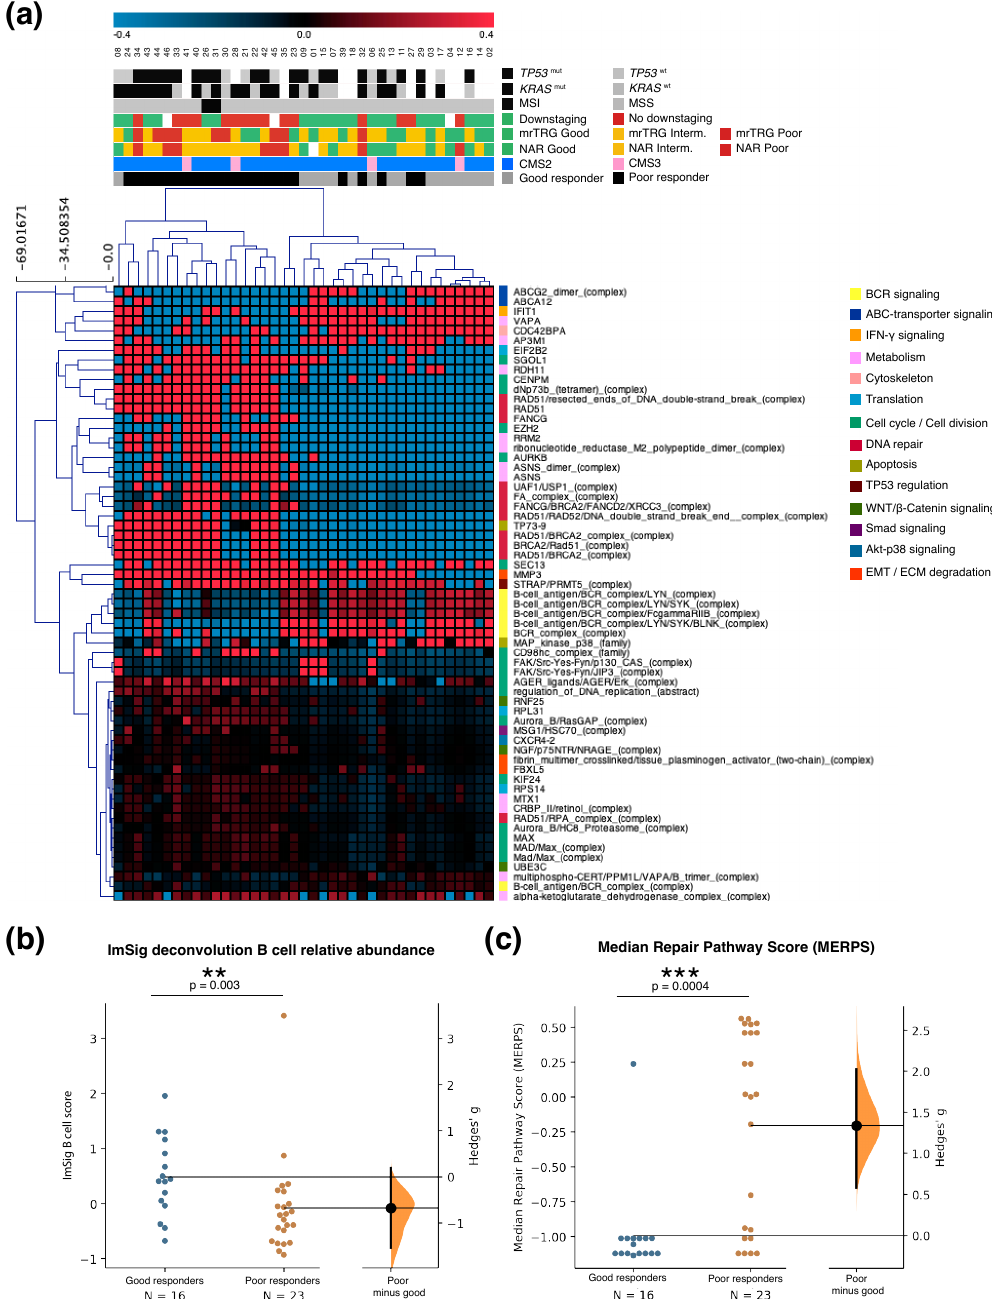
Figure 2. Differential gene expression analysis in good vs poor responders in the LARC cohort. ( a ) Heatmap of the 65 differential PARADIGM terms ( t -test p < 0.005) between good and poor responders (columns), clustered by Pearson correlation. The upper panel depicts a category plot that summarizes the responder class of each patient according to the response evaluation methods (i.e., mrTRG, Consensus Response, NAR), as well as other relevant variables (downstaging, consensus molecular subtype [CMS] class, presence/absence of TP53 and/or KRAS mutations, microsatellite instability [MSI] status). The red/blue bar of the top panel shows the range of median centered Integrated Pathway Activity scores from PARADIGM. Red terms correspond to higher pathway activation scores while blue represents lower scores. The lateral color code on the right of